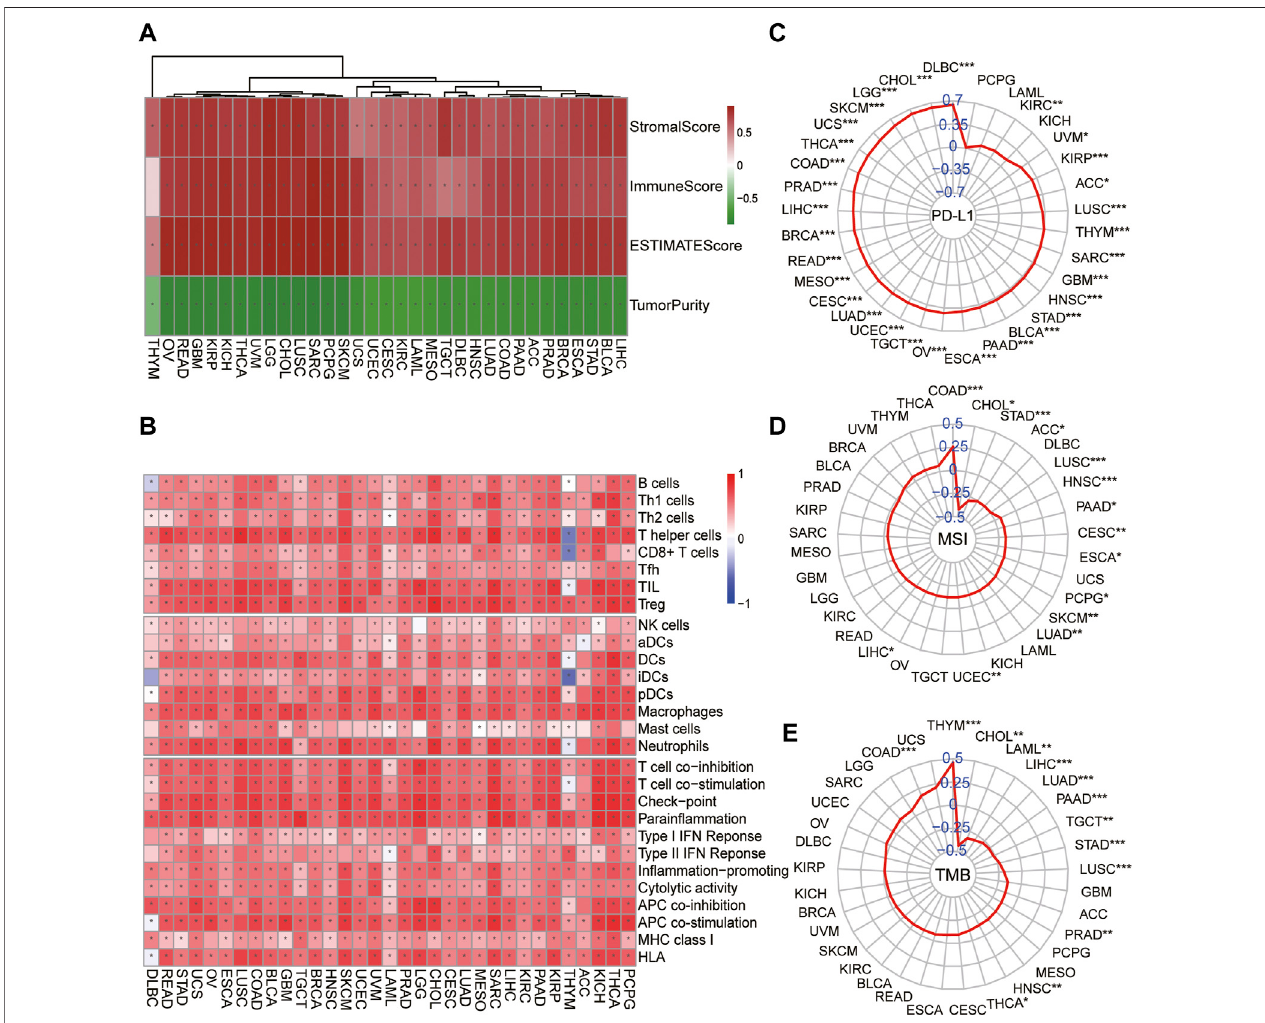
FIGURE6| Correlationofferroptosis-relatedmodule – genewithimmunityinpan-cancer.Heatmapoftheenrichmentscoreandimmunescores (A) or28typesofimmunecells (B) in 33 types of cancer. * p < 0.05 was calculated using the Spearman analysis. The correlation of the enrichment score and PD-L1 mRNA expression (C) , MSI (D) , and TMB (E) across 33 types of cancer. The coef fi cient was evaluated by the Spearman analysis and the results were presented as radar maps (* p < 0.05; ** p < 0.01; *** p < 0.001).